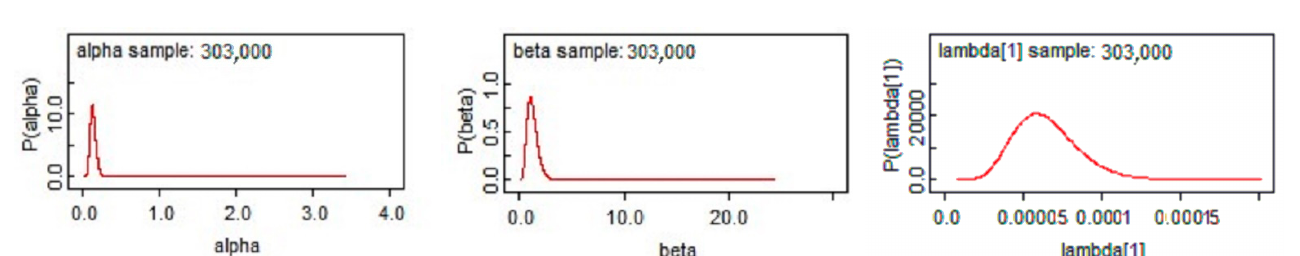
Figure 6. The trace of (cid:2019) in the Markov chain Monte Carlo (MCMC) sampling.